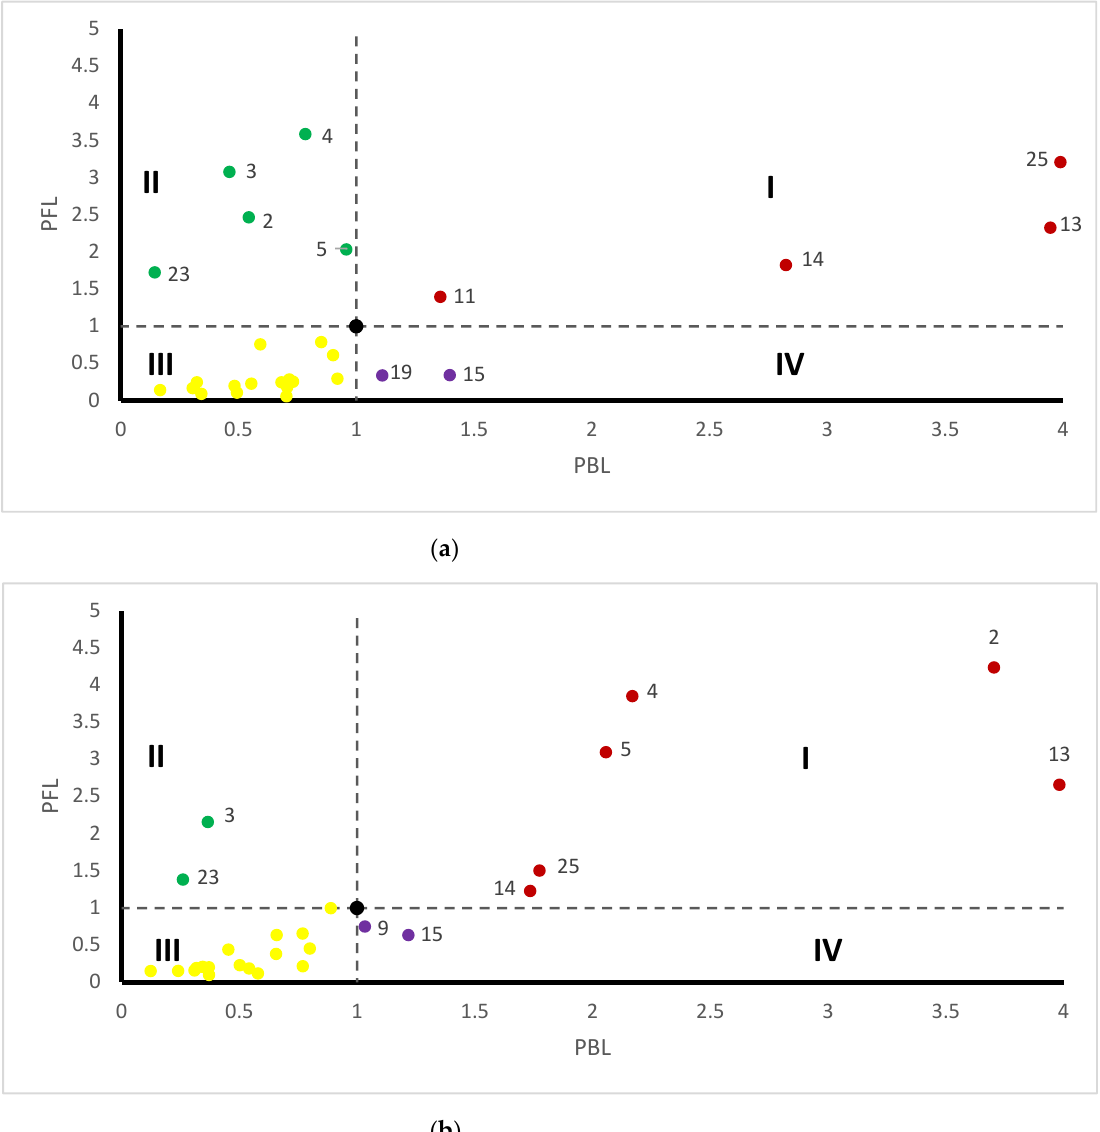
Figure 5. The influence and sensitivity coefficients of NO x and PM in 27 sectors. ( a ) NO x ; ( b ) PM. The influence and sensitivity coefficients of the sectors in the quadrant III are less than the threshold value 1, which is not the focus of our research. Therefore, the sectors represented by the yellow scatter is not marked.